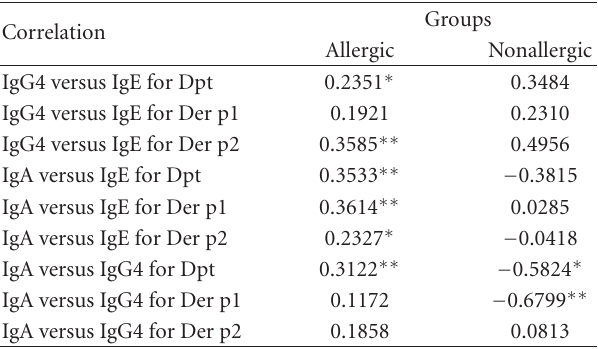
Table 3: Correlation between serum IgG4, IgA, and IgE levels to Dermatophagoides pteronyssinus (Dpt) crude extract and its major allergens (Der p1 e Der p2) in allergic and nonallergic